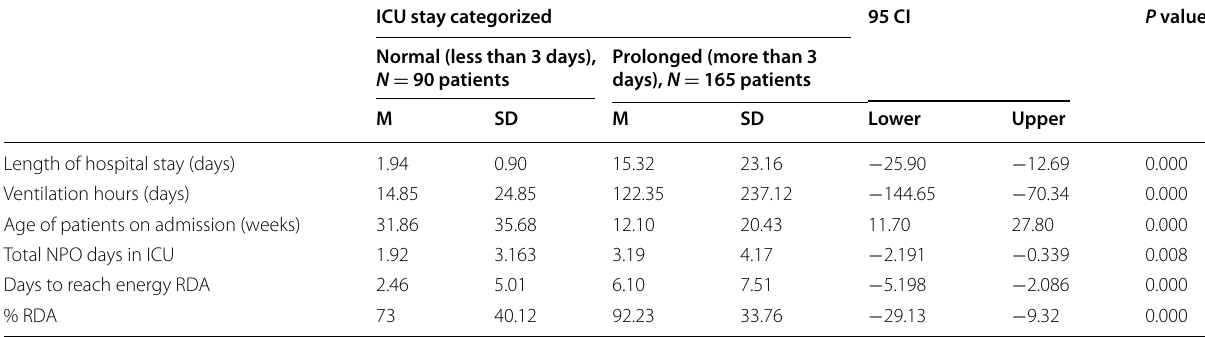
Table 3 Relationship between ICU stay and continuous risk factors